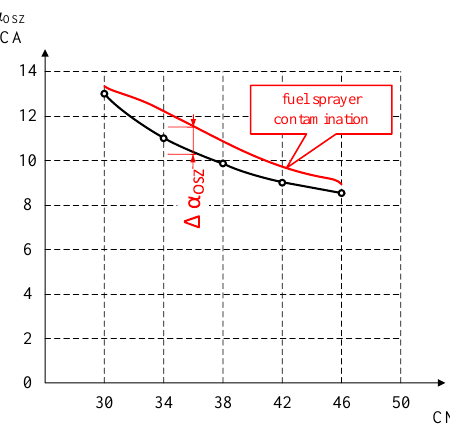
Fig. 6. Characteristics of the fuel self-ignition delay in the CFR F5 test engine as a function of the cetane number [4, 14,